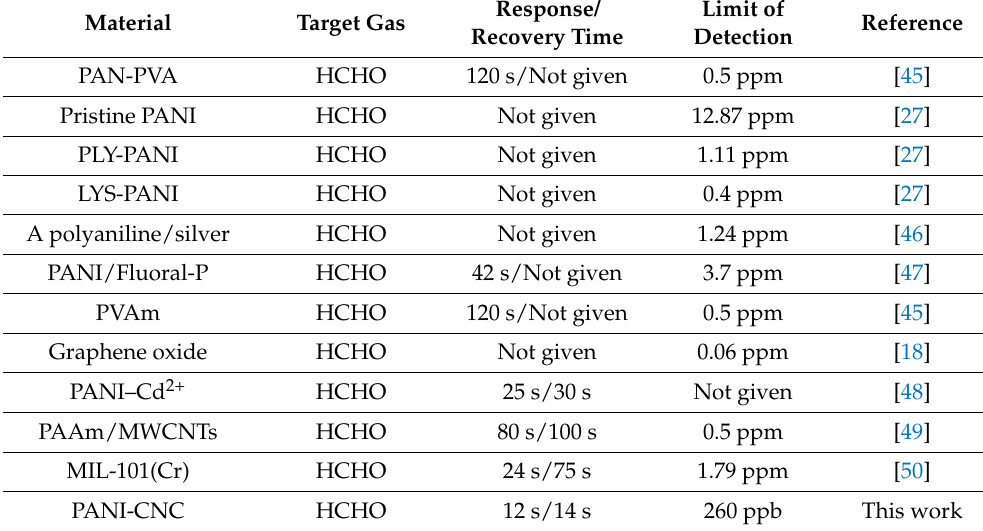
Table 1. Room-temperature detection properties of various sensing materials based on QCM.